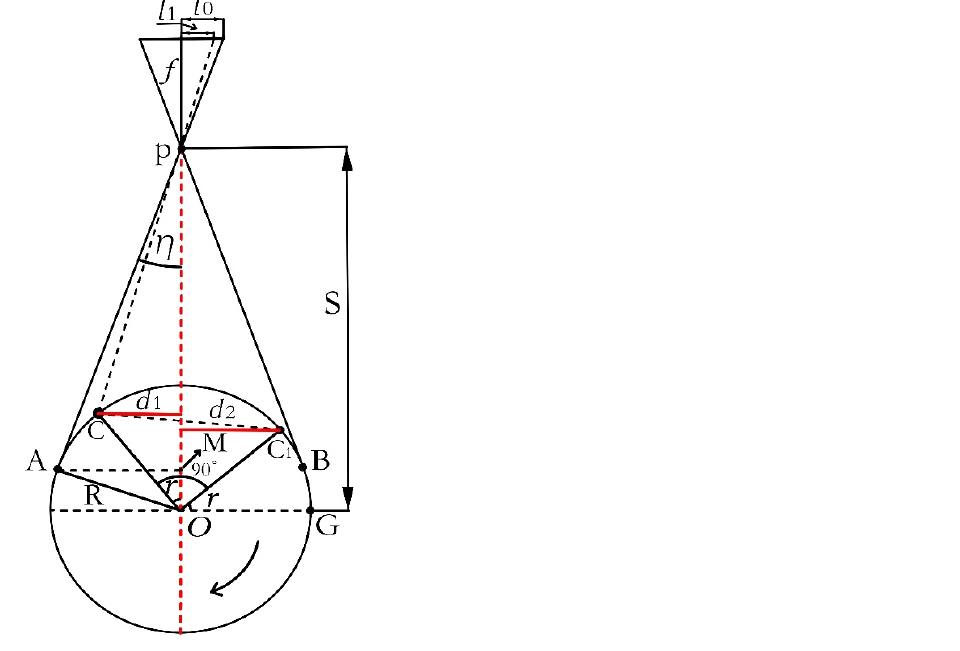
Figure 5. Schematic diagram of the 90° rotation distance of the pineapple eye center